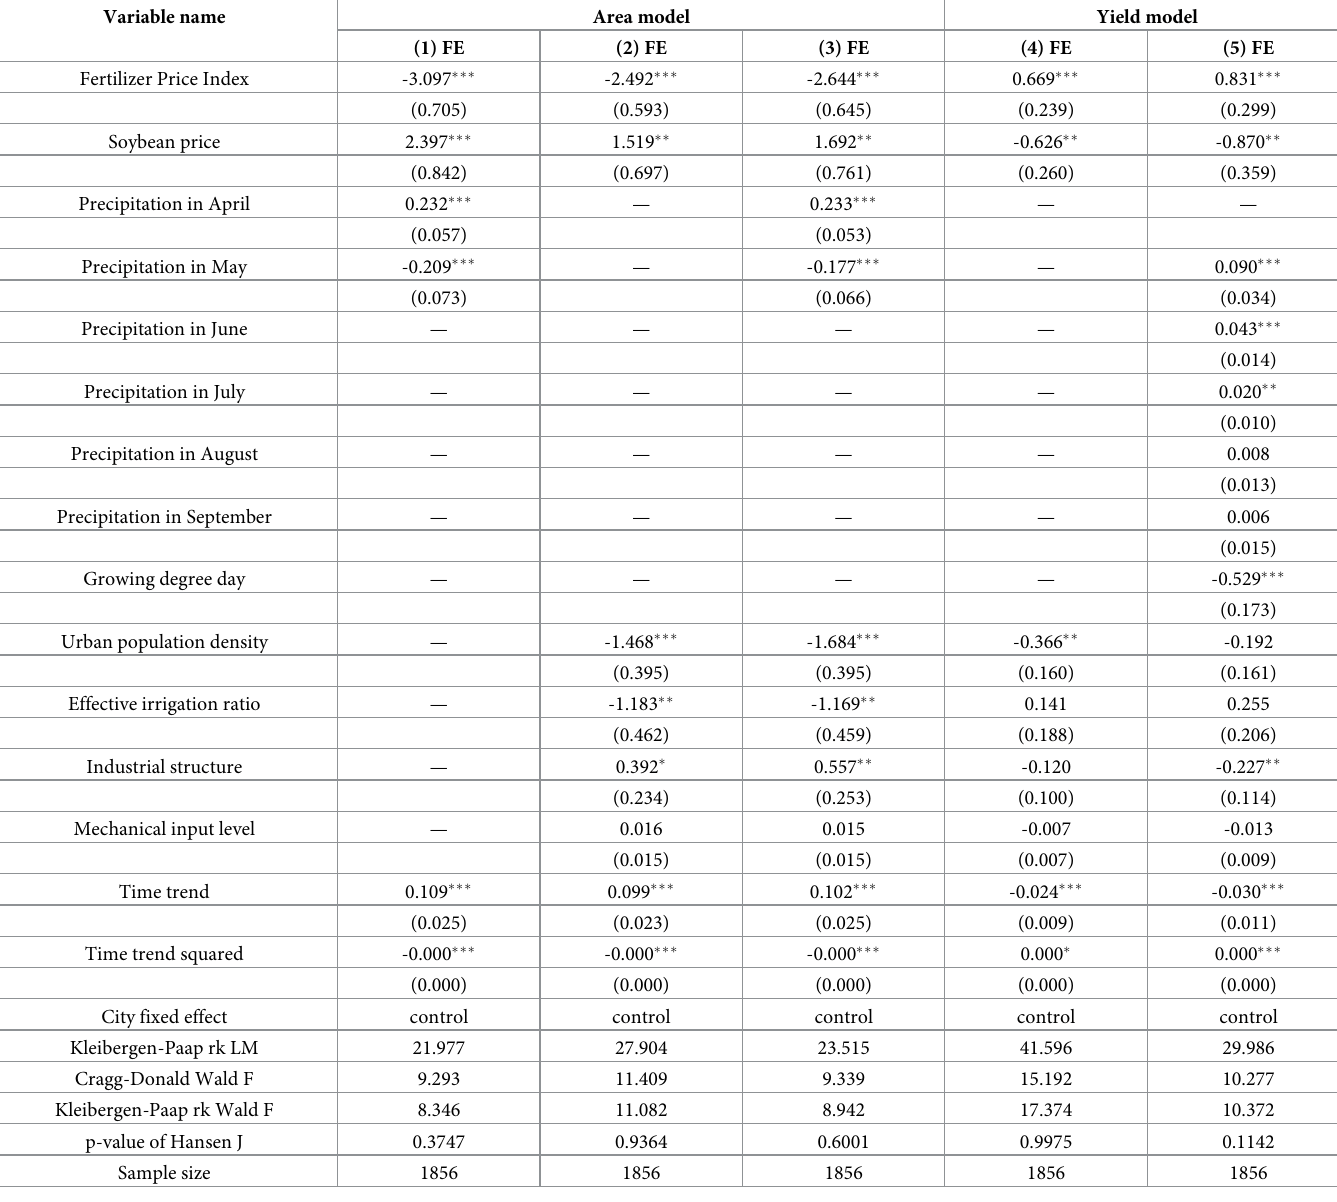
Table 3. Regression results of the fixed effect